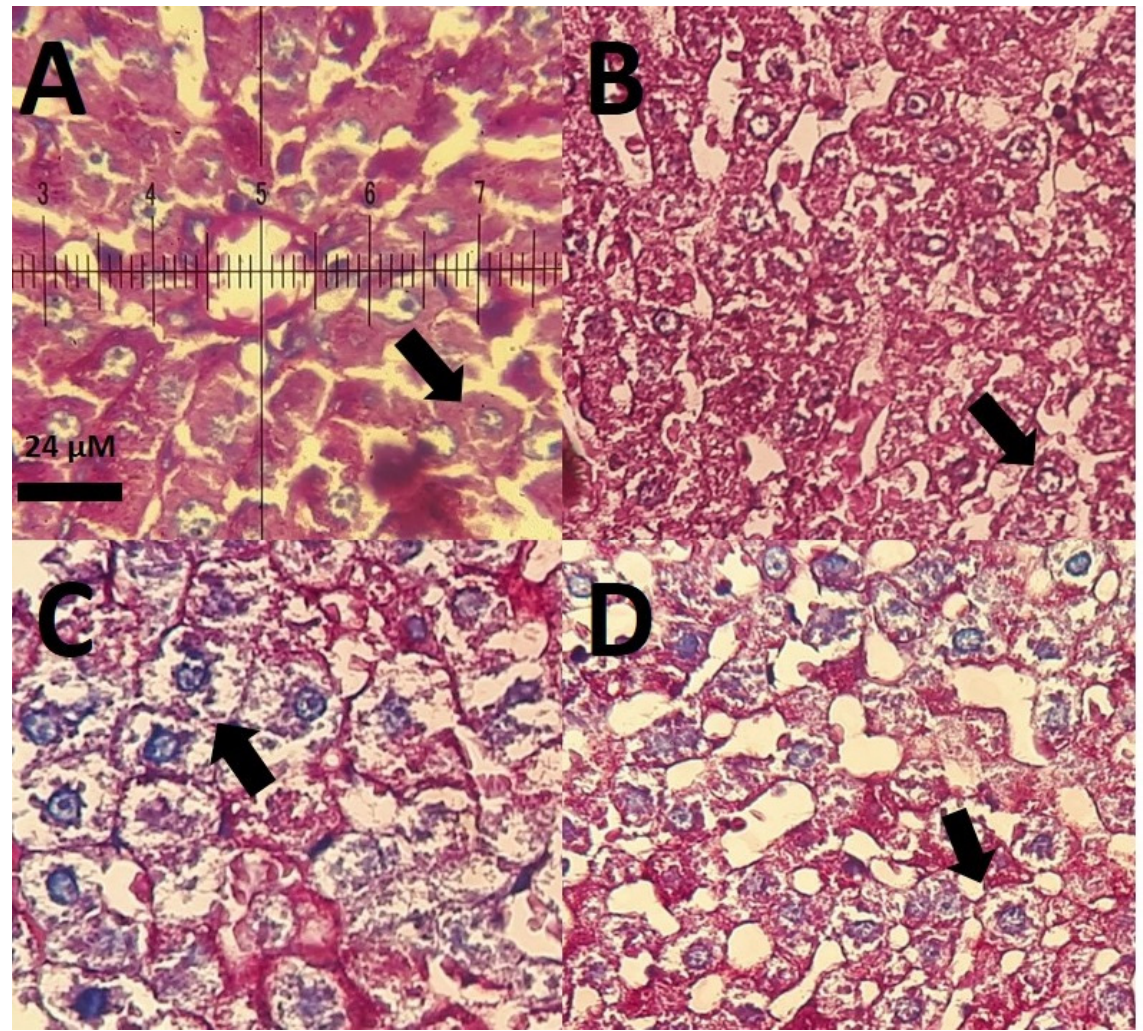
Figure 6. ( A ) Alcian blue-stained section liver section of a control rat showing normal hepatocytes, well-arranged hepatic cords, normal portal triads, and normal central vein (CV). Bar = 24 µ m ( × 40). ( B ) Liver section of a rat received the 30 mg/kg dose of curcumin microemulsions, showing normal morphology of hepatocytes (arrow) and well-arranged hepatic cords. As seen, no histopathological injury is observed. Alcian blue staining ( × 40). ( C ) liver sections of a rat thioacetamide-treated rat, intensive intra-cytoplasmic fat deposition is observed (arrow); ( D ) liver section of a thioacetamide-intoxicated rat treated with intraperitoneal injections of 30 mg/kg curcumin microemulsions, showing a reduction in cytoplasmic vacuolation (arrow point). Alcian blue staining (40× magnification). Scale bar indicates 40 μ m.